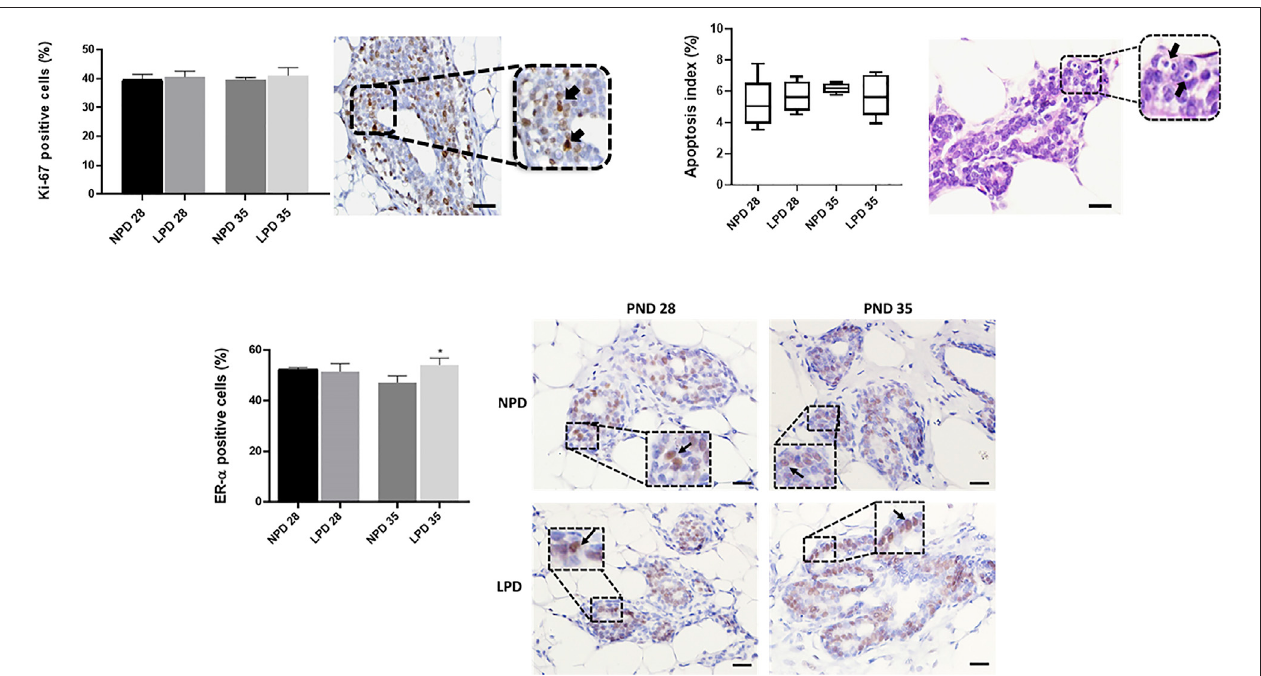
FIGURE 5 | Analysis of cell proliferation, apoptosis, and ER- α in mammary epithelial cells. Labeling index (%) and representative photomicrographs of positive mammary epithelial cells for Ki-67, apoptosis, and ER- α (black arrows) (scale bar (cid:1) 20 µm). Ki-67 and ER- α values are expressed as mean ± standard deviation and apoptosis values are median and interquartile range (25% – 75%). The p values toKi-67and ER- α were obtained byStudent t test and post hoc Mann – Whitneyrank test to apoptosis values. *Signi fi cant different from NPD35( p ≤ 0.007). NPD, normoprotein diet; LPD, low-protein diet. Postnatal day of MNU administration (28 or 35).